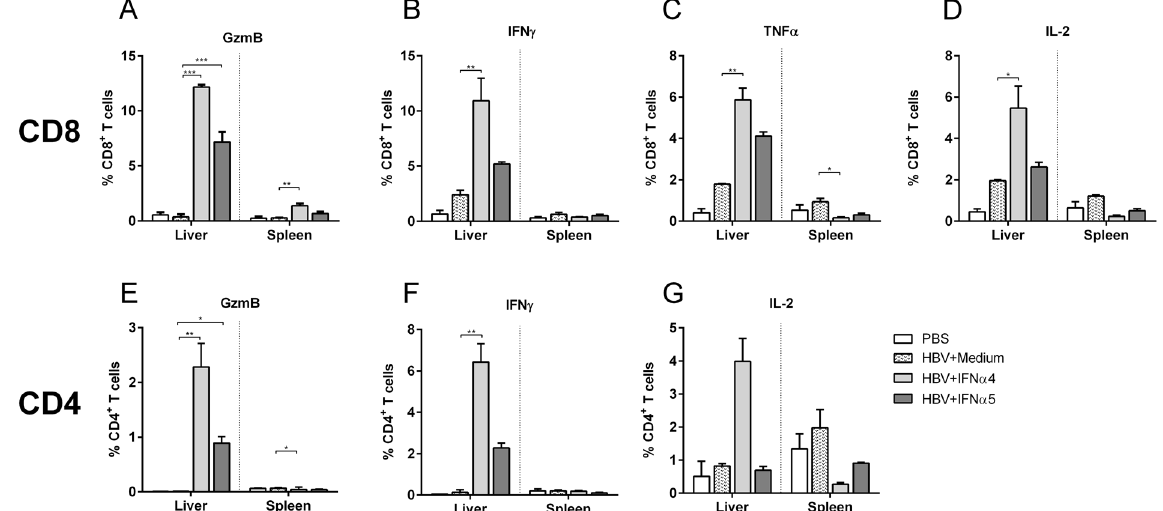
Figure 4. Analysis of CD8 + and CD4 + T cells from IFN α 4 or IFN α 5-treated mice. Mice received HI with 10 µ g of pAAV-HBV1.2 plasmids. Mice were treated i.p. with 8000 units of recombinant IFN α 4 or α 5 protein starting from days − 1 to 9 post HI. Control mice received either HI with PBS (PBS) or were treated i.p. with media (HBV + Medium). At day 10 post HI mice were sacrificed and nucleated cells from liver and spleen were analyzed by flow cytometry for expression of T cell-specific surface markers and intracellular cytokines. Frequencies of GzmB ( A ), IFN γ ( B ), TNF α ( C ) and IL-2- producing CD8 + T cells ( D ), GzmB ( E ), IFN γ ( F ) and IL-2-producing CD4 + T cells ( G ) were shown. At least four mice per group were analyzed. Differences between the groups were analyzed by using the One-way ANOVA. Statistically significant differences between the IFN-treated groups and the untreated control group are indicated by * for p < 0.05, ** for p < 0.01 and *** for p <